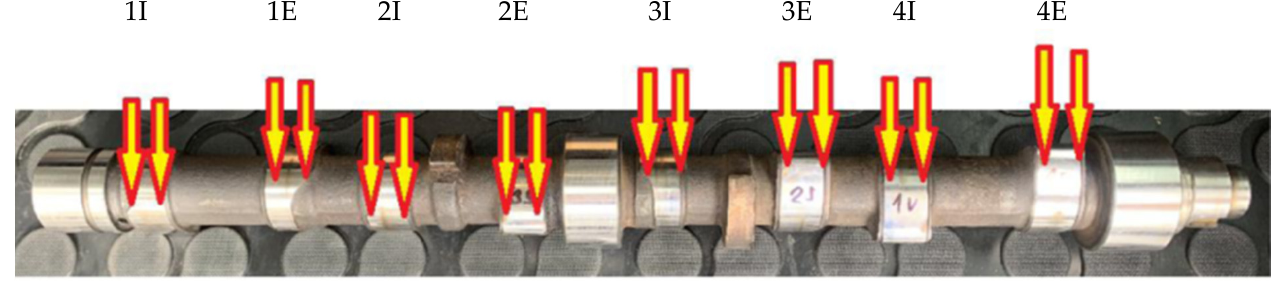
Figure 4. Camshaft sampling spots (I—intake cam, E—exhaust cam).